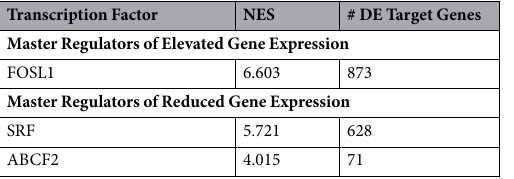
Table 1. Master regulators of Oncopig STS cell lines. Transcription factors whose target genes were enriched (normalized enrichment score (NES) > 4) among the differentially expressed (DE) genes displaying either elevated or reduced expression.